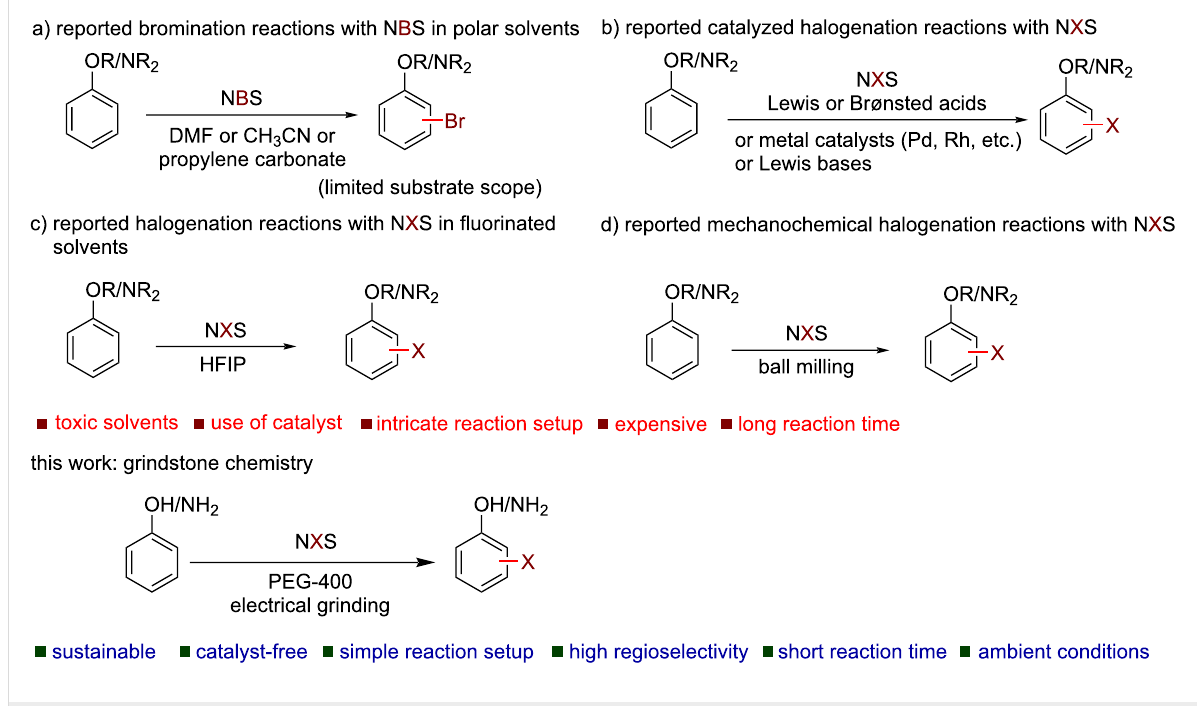
Scheme 1: Strategies for halogenation of aromatic compounds using NXS.